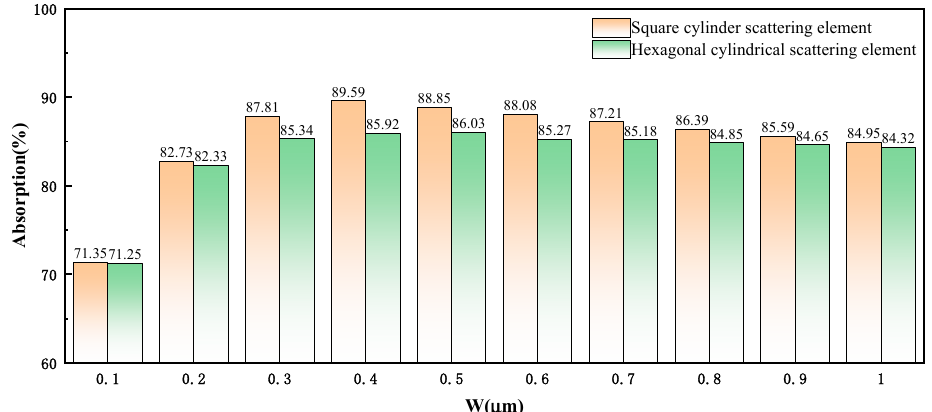
Figure 6. The effect of side length W for two different types of scatterers on the absorption efficiency of the absorption layer.